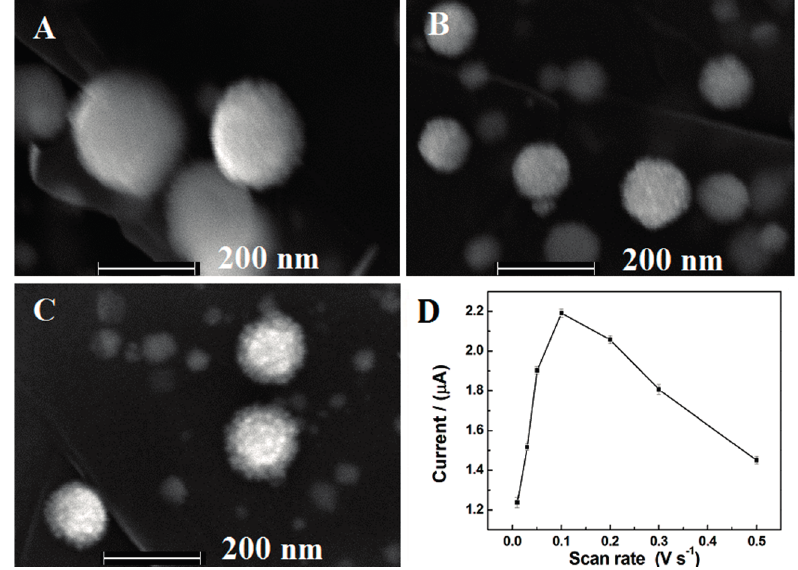
Figure 4. FESEM images of Pt-Au/rGSs hybrid films with different scan rates: ( A ) 50 mV·s − 1 ; ( B ) 100 mV·s − 1 and ( C ) 500 mV·s − 1 ; ( D ) plots of the peak current for the Pt-Au/rGSs/GCE in the presence of 0.1 mM H 2 O 2 vs. different electrodeposition scan